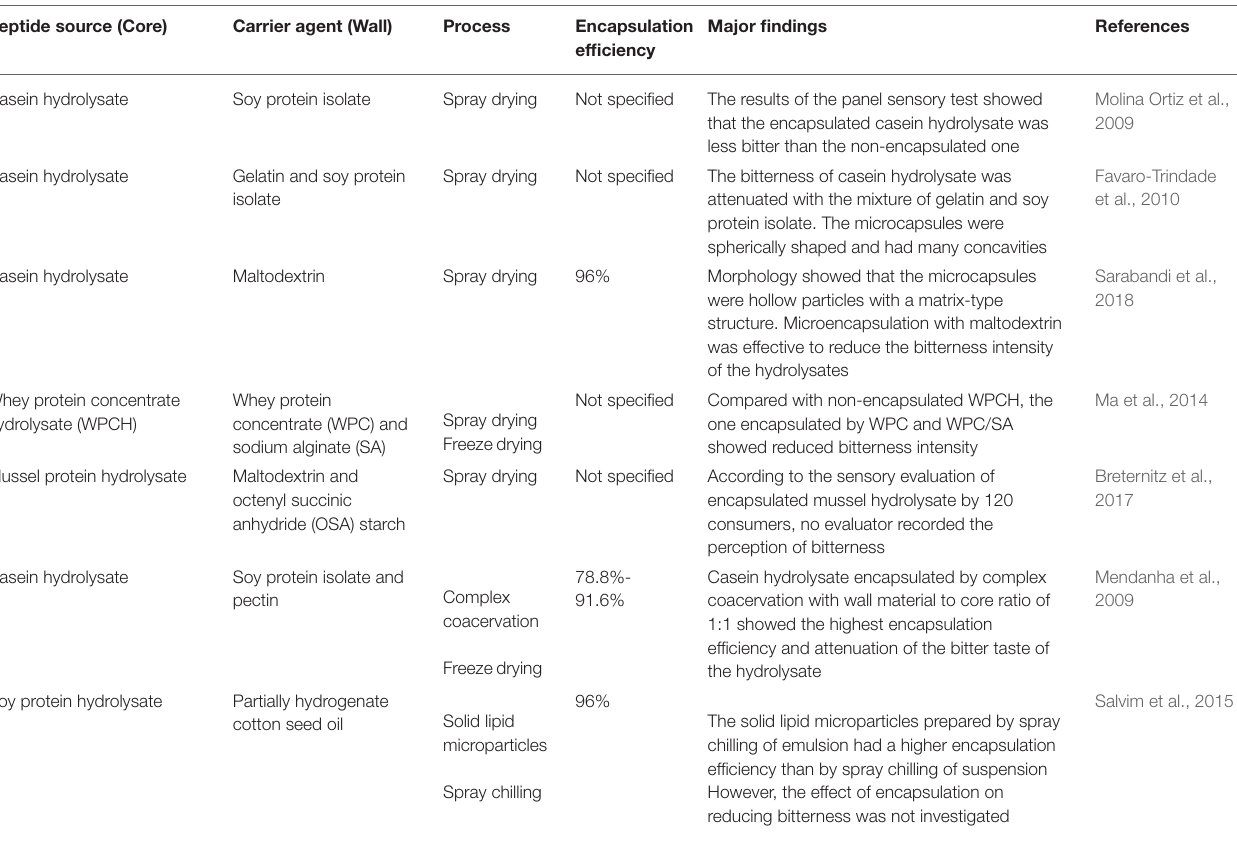
TABLE 6 | Examples of encapsulation of food protein hydrolysates and peptides. Peptide source